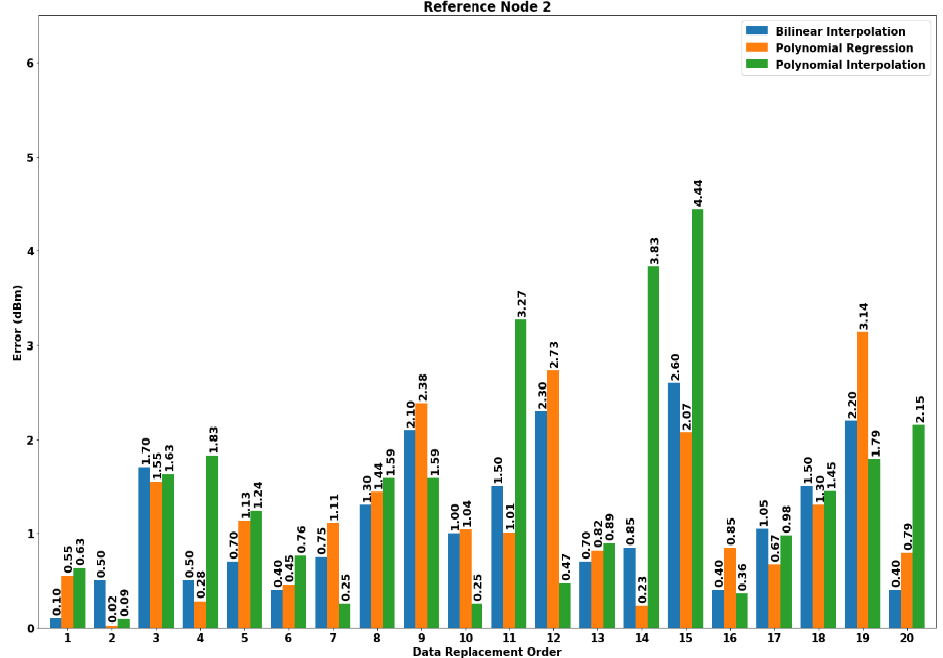
node 2. The brighter colour gradation is origin from the bottom right as the reference node two positions in the measurement.